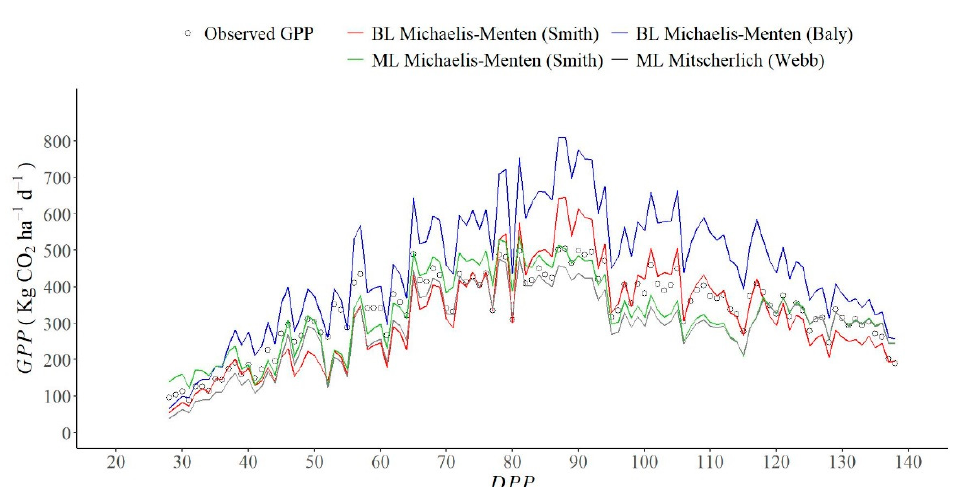
Figure 6. Daily gross primary production (GPP) estimated with the scaling up Big-Leaf—BL (red, blue solid lines) and Multilayer—ML (green, black solid lines) models and Eddy Covariance—EC measurements (open circles), Vs. days post planting (DPP).